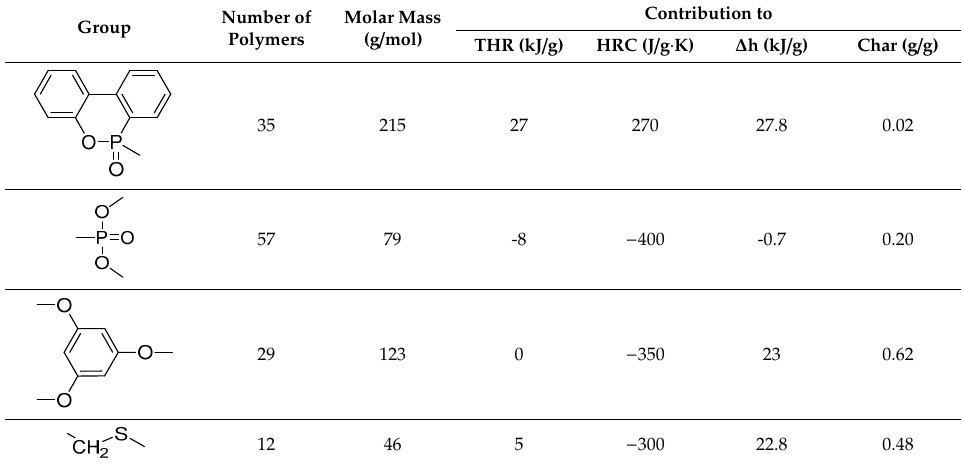
Table 2. List of polymers tested in the present study. DOPO—9,10-dihydro-9-oxa-10- phosphaphenanthrene-10-oxide; MAPC1—dimethyl(methacryloxy)methyl phosphonate; MANP2C3— 2-(bis((dimethoxyphosphoyl)methyl)amino)ethyl methacrylate. Series Description DOPO-containing acrylate and A methacrylate co-polymers MAPC1 and MANP2C3-containing B methacrylate random co-polymers MAPC1-containing methacrylate block co-polymers Phosphonate-containing epoxy thermosets (including trioxybenzene group